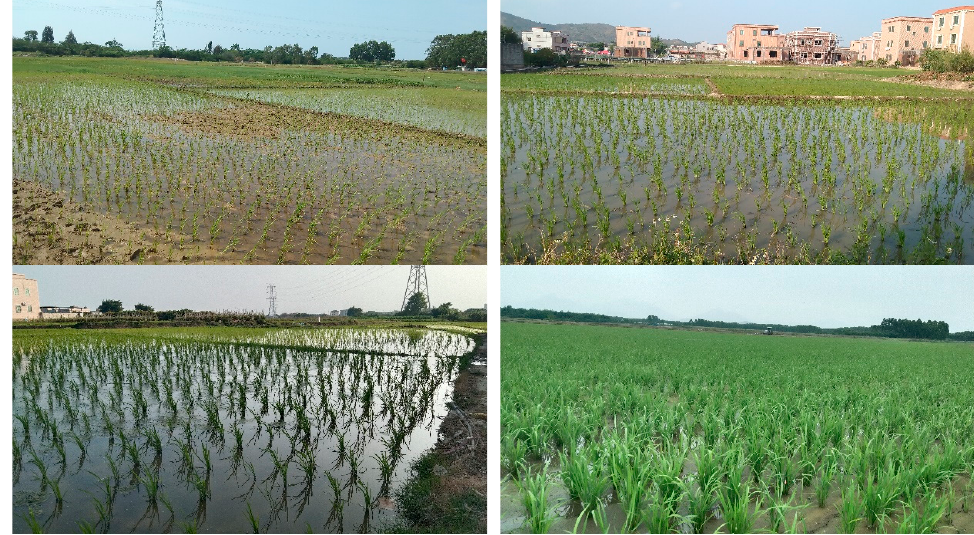
Figure 2. Examples of field survey.